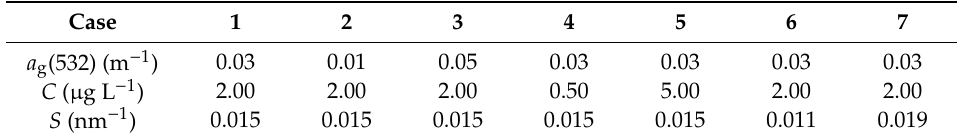
Table 1. Input seawater optical properties in the